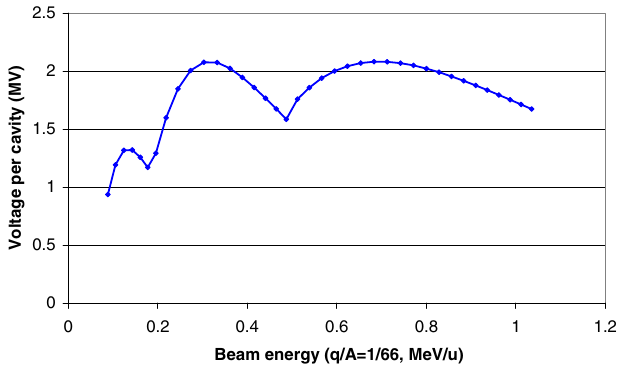
FIG. 1. (Color) Voltage gain per cavity as a function of ion beam energy, q=A (cid:1) 1 = 66 , Injection energy is 75 keV =u .